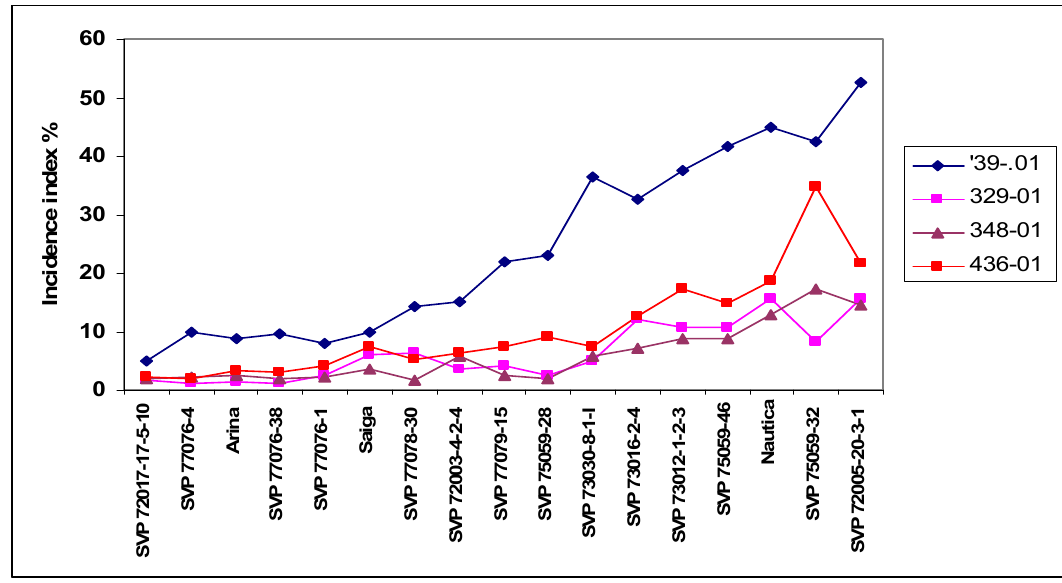
Figure 4. Incidence of 17 winter wheat genotypes against four isolates of F. culmorum across three years, IPO Wageningen, Snijders and van Eeuwijk [39].